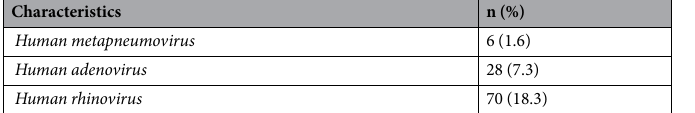
Table 1. Baseline characteristics of ARI patients (n = 383). Data in the table are number of patients and percentages, except for a few variables for which the unit is specified. Because of missing values, superscript numbers indicate the number of patients for whom data were available. Low birth weight: defined by